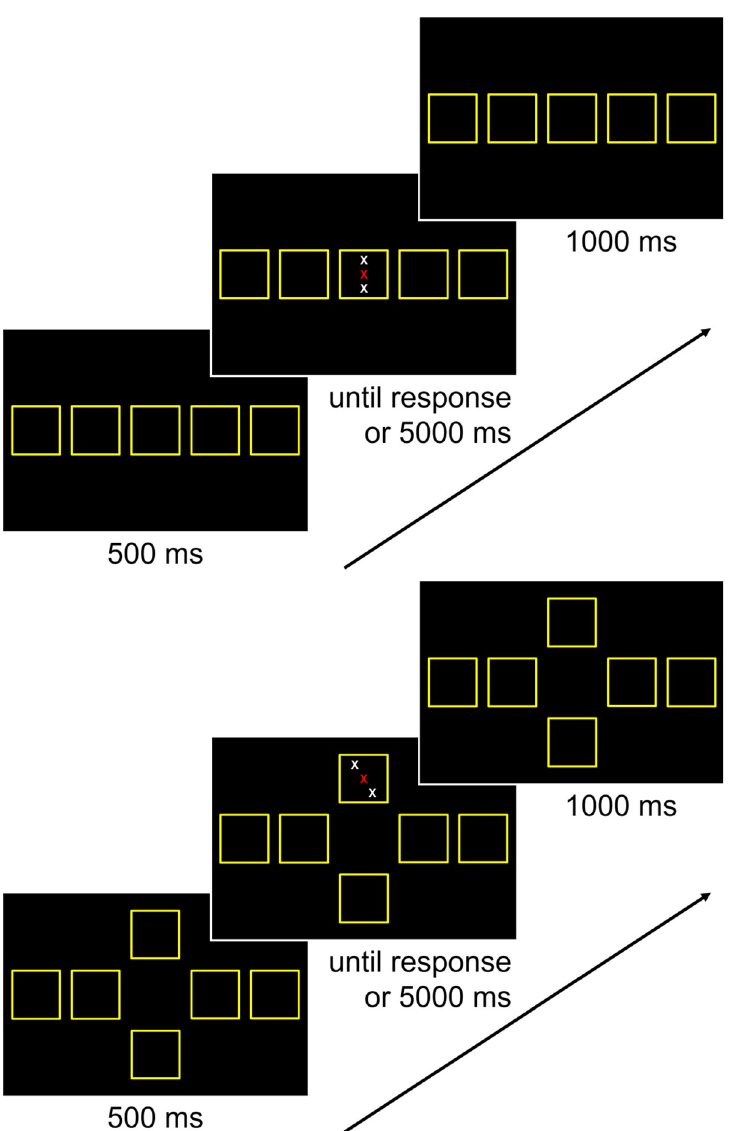
Fig 4. Experiment 1: Example of one trial sequence. Participants were asked to indicate the color of the central letter while ignoring the flanking letters and their location on the screen. They used the four response keys y , v , m , and - , which were mapped to the colors red, brown, violet, and white, respectively. Top part: Experiment 1a. Bottom part: Experiment